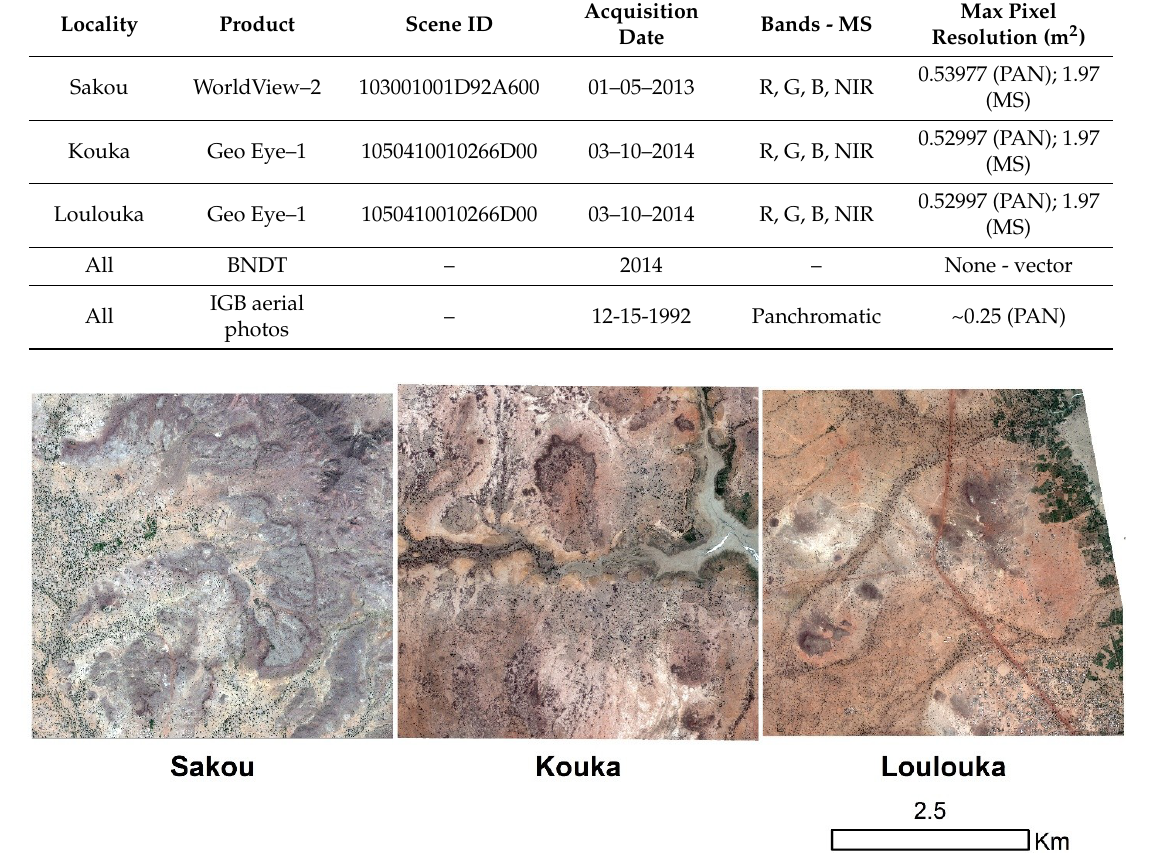
Figure 6. Study localities and multispectral satellite images (3, 2, 1 – true color).